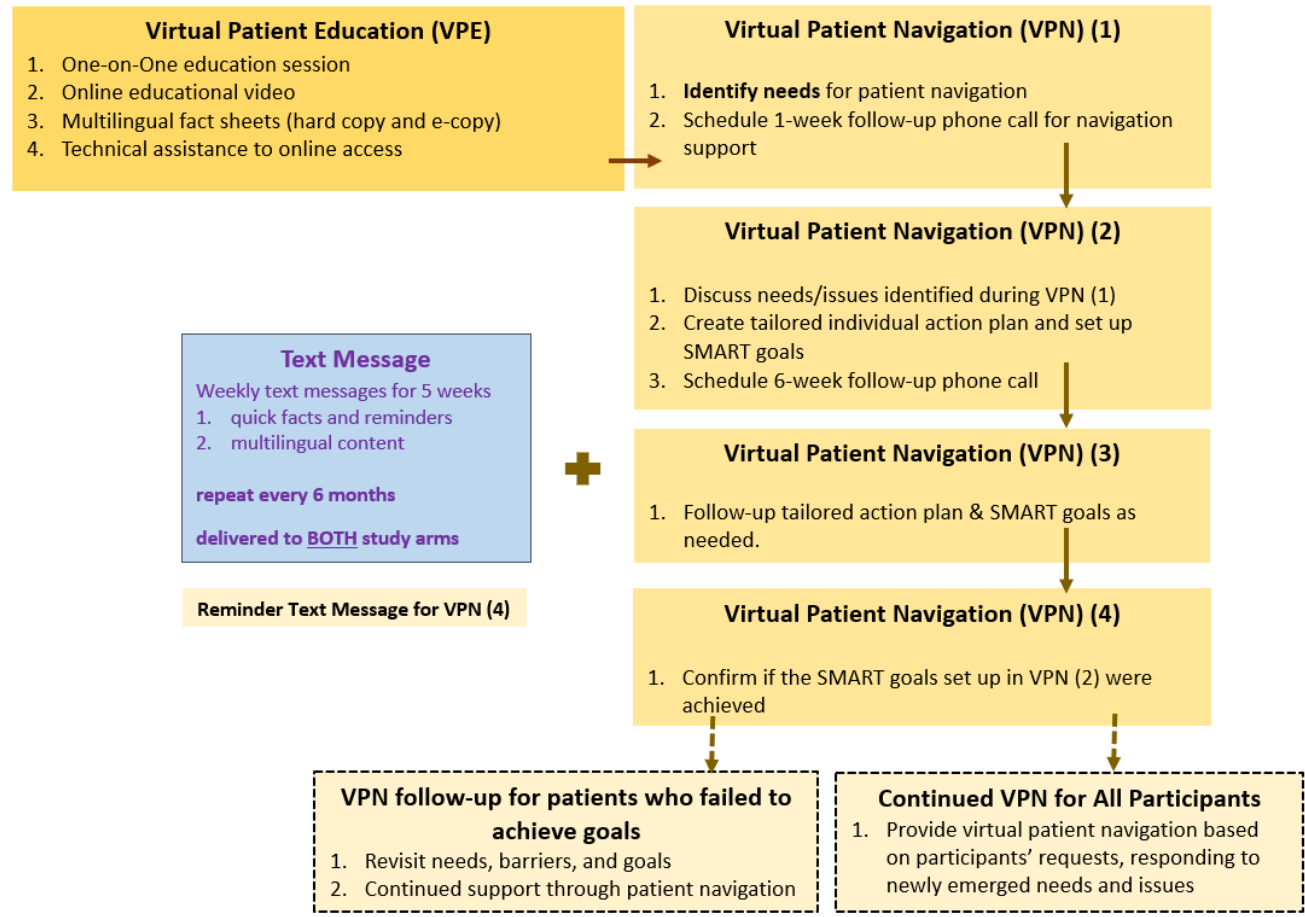
Figure 2. Multicomponent Intervention Flow Chart.